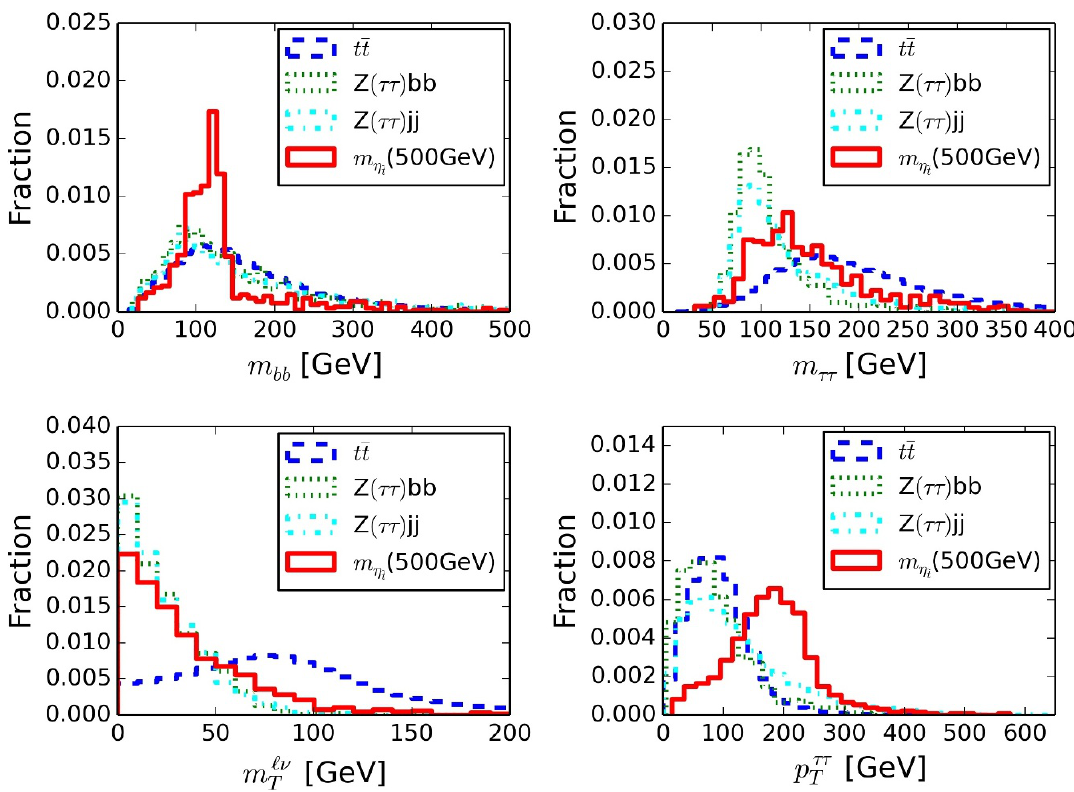
Figure 3 . Distributions of the di-tau invariant mass m (cid:28)(cid:28) , two b -jets invariant mass m bb , the transverse mass of the lepton plus missing energy system m ‘(cid:23) p (cid:28)(cid:28) . The stoponium mass is taken as m (cid:17) T background Z ! (cid:28)(cid:28) is achieved. This selection also has the advantage of reducing the QCD multijet